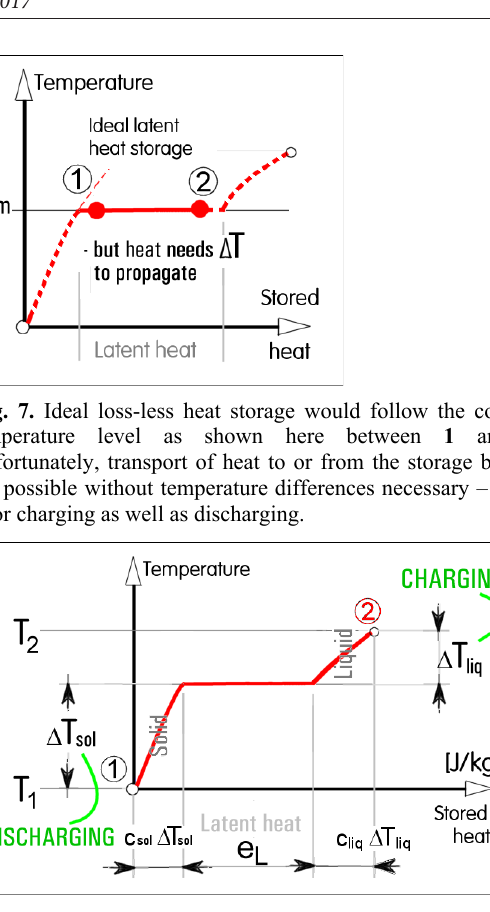
Fig. 8. Actual latent-heat storage contains the inevitable conductivity-governed transport into or from the storage material. The inevitable conduction parts of charging and discharging, between 1 and T m as well as between T m and 2 , decrease storage efficiency.